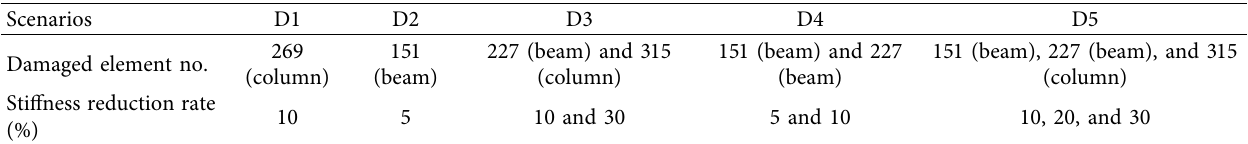
Table 3: Damage scenarios of 10-storey setback building.